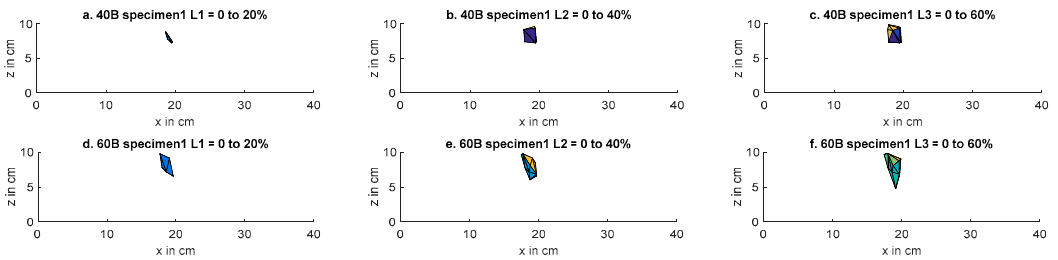
Figure 14. CHV progression seen along the side elevation ( x -and z -axis) for L1, L2, and L3 for specimens WC40B1 ( a – c ), and WC60B1 ( d – f ).